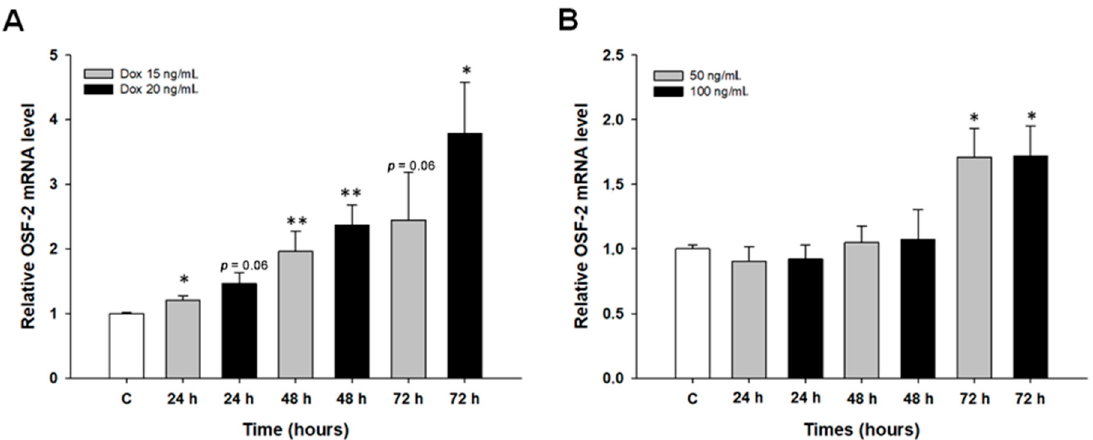
Figure 4. Expression analysis of the OSF-2 gene in the W1 cell line after a short period of exposure to DOX, with ( A ) a maximum increase in transcript level of about 3.5-fold after 72 h of treatment, and ( B ) a maximum increase in transcript level of about 1.7-fold with MTX after 72 h of treatment. The figure presents relative gene expression in DOX- or PAC-treated cells (grey and black bars) with respect to the untreated control (white bars) assigned as 1. The values were considered significant at * p < 0.05, and ** p < 0.01.